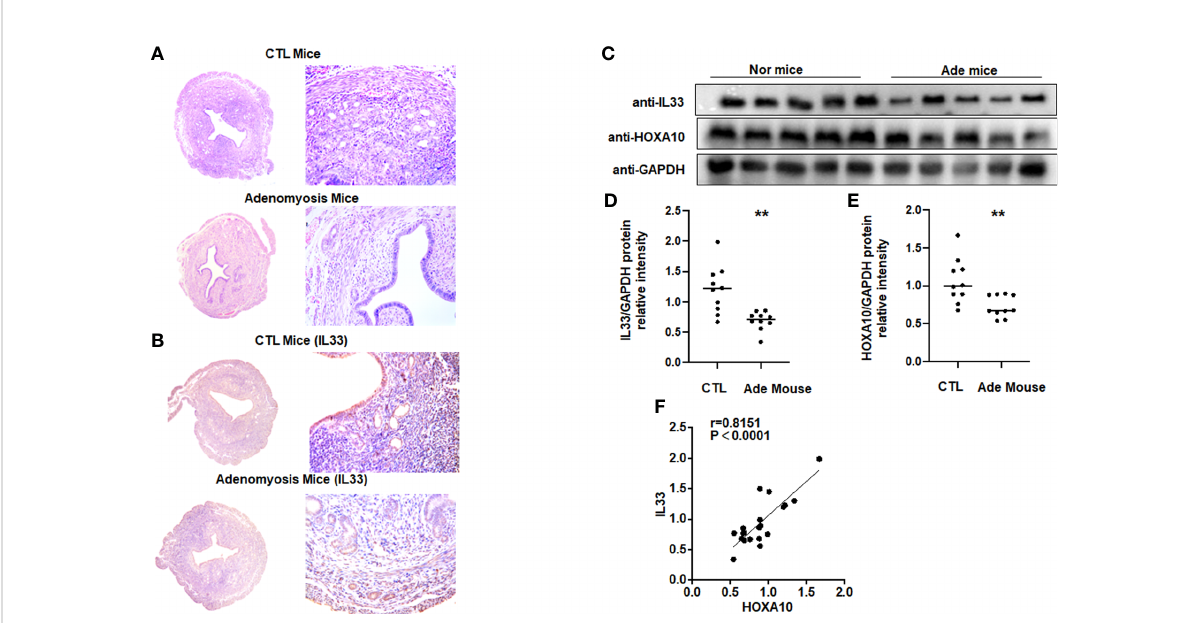
FIGURE 6 IL33 expression is decreased in a mouse model of adenomyosis. (A) HE staining con fi rmed that the mouse model of adenomyosis was successfully constructed. (B) Uterus from control mouse and adenomyosis mouse model were analyzed using immunohistochemistry (IHC). Rabbit IgG was used as the negative control. The arrows show the decreased IL33 conjugates in the endometrial cell epithelium. (C) IL33 and HOXA10 protein expression in control (n =10) and mouse with adenomyosis (n=10) was analyzed by Western blot. (D) The intensities of IL33 signals were quanti fi ed from the 10 samples and normalized to GAPDH. **p < 0.01. (E) The intensities of HOXA10 signals were quanti fi ed from the 10 samples and normalized to GAPDH. **p < 0.01. (F) Correlation between IL33 and HOXA10 protein expression levels (r = 0.8151, p <